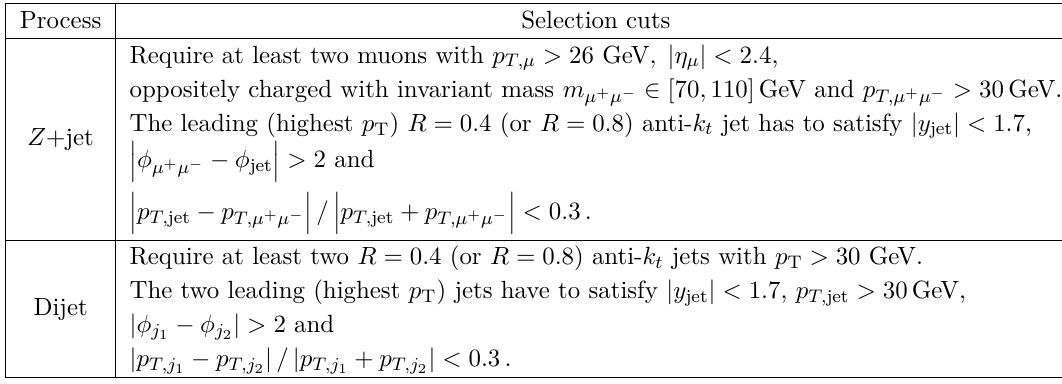
Table 1. Event-selection cuts used by the CMS collaboration in [30]. The muons used to reconstruct the Z boson are considered as “bare”, i.e. without QED emissions, and are excluded from the input to the jet